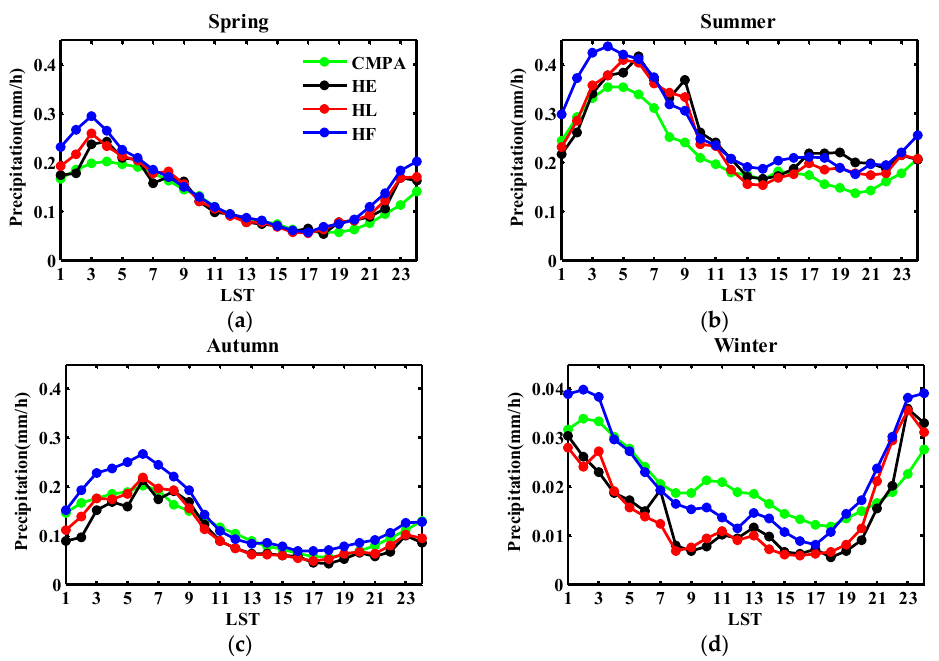
Figure 7. Diurnal cycle of precipitation averaged in each season over Sichuan Basin during 2016 to 2018: ( a – d ) represent spring, summer, autumn, and winter, respectively. Table 3. The continuous statistical metrics of the diurnal precipitation cycle for each season over the Sichuan Basin during 2016 to 2018 .